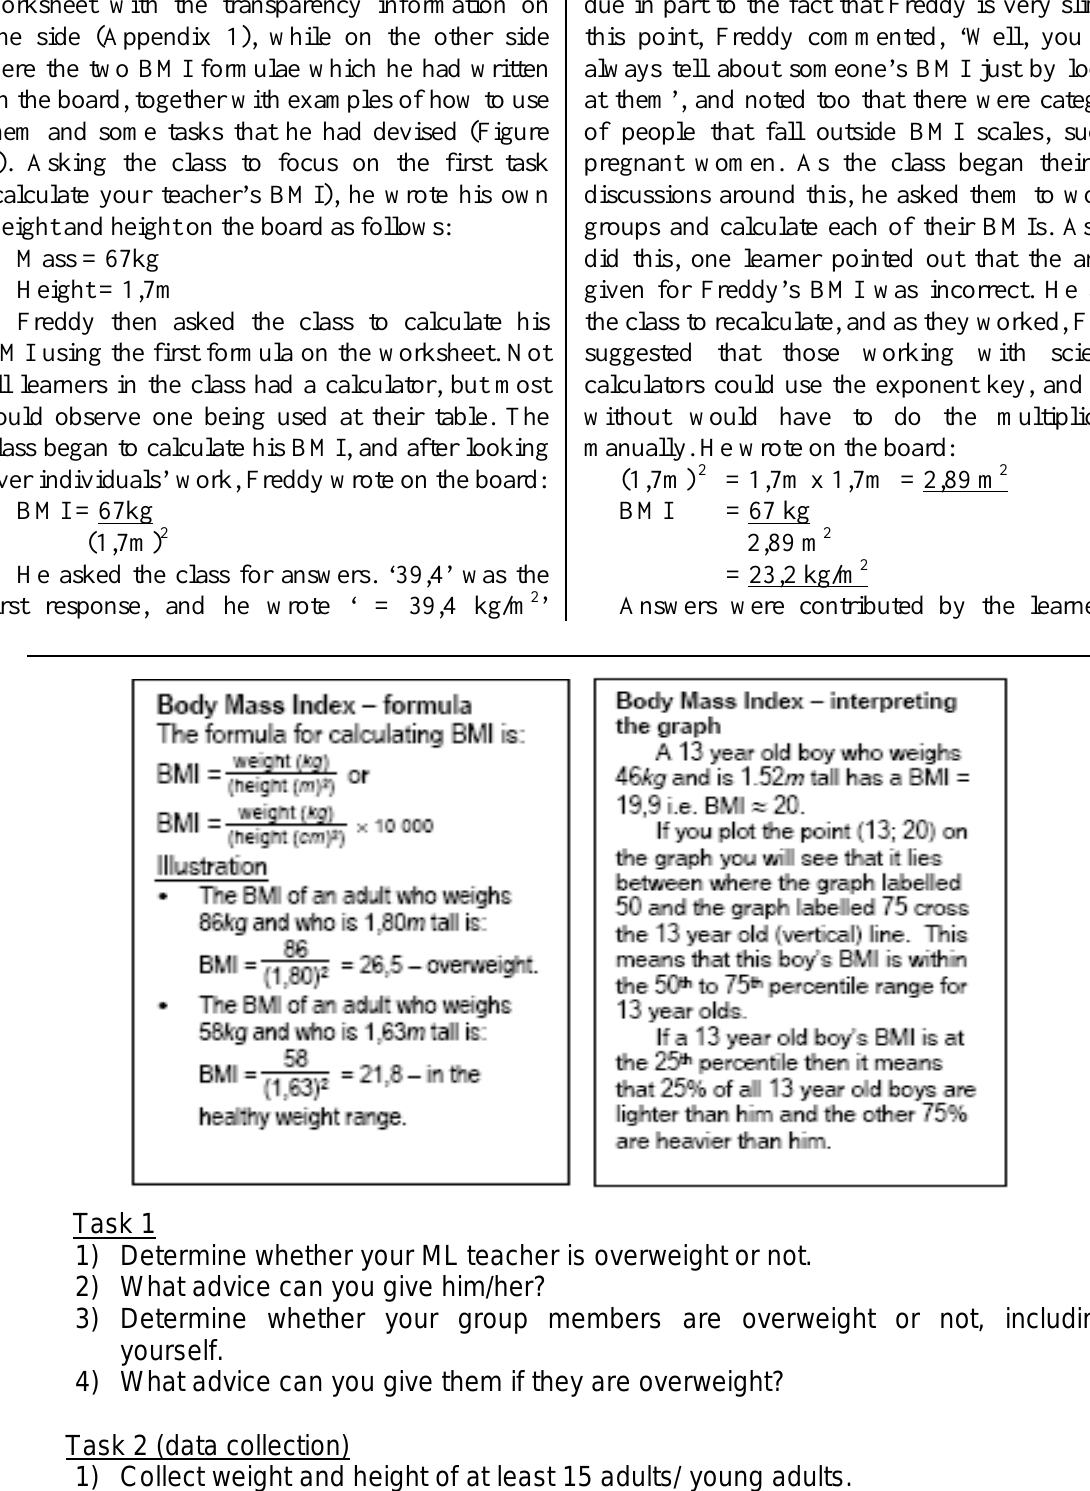
Figure 1. Worksheet with formulae and classroom